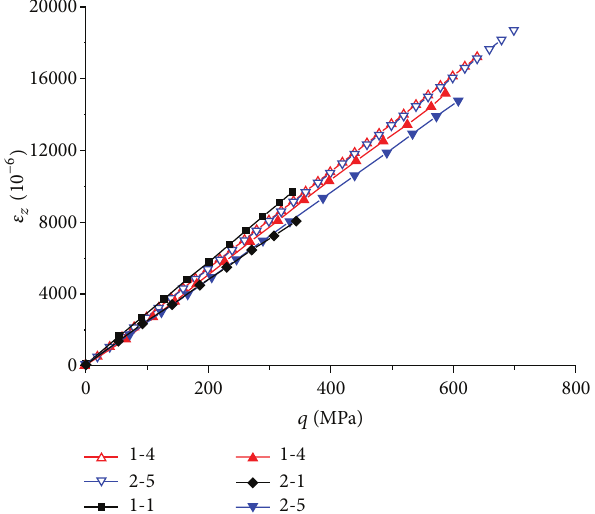
Figure 5: Comparison between the theoretical and experimental results on the 𝜀 𝑧 - 𝑞 relation of different specimens.